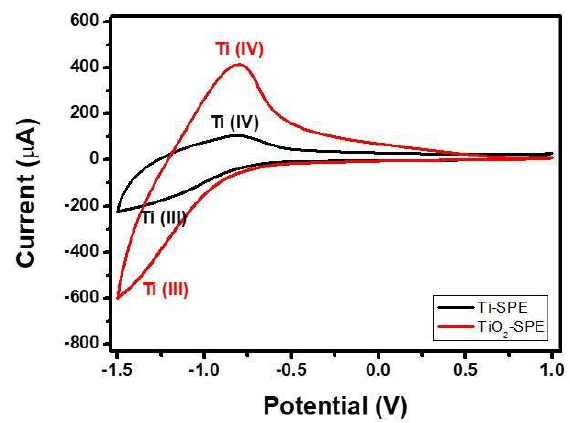
Figure 5. CV of bare Ti-SPE and TiO 2 -SPE electrodes in PBS (pH = 7) at 50 mV s − 1 .